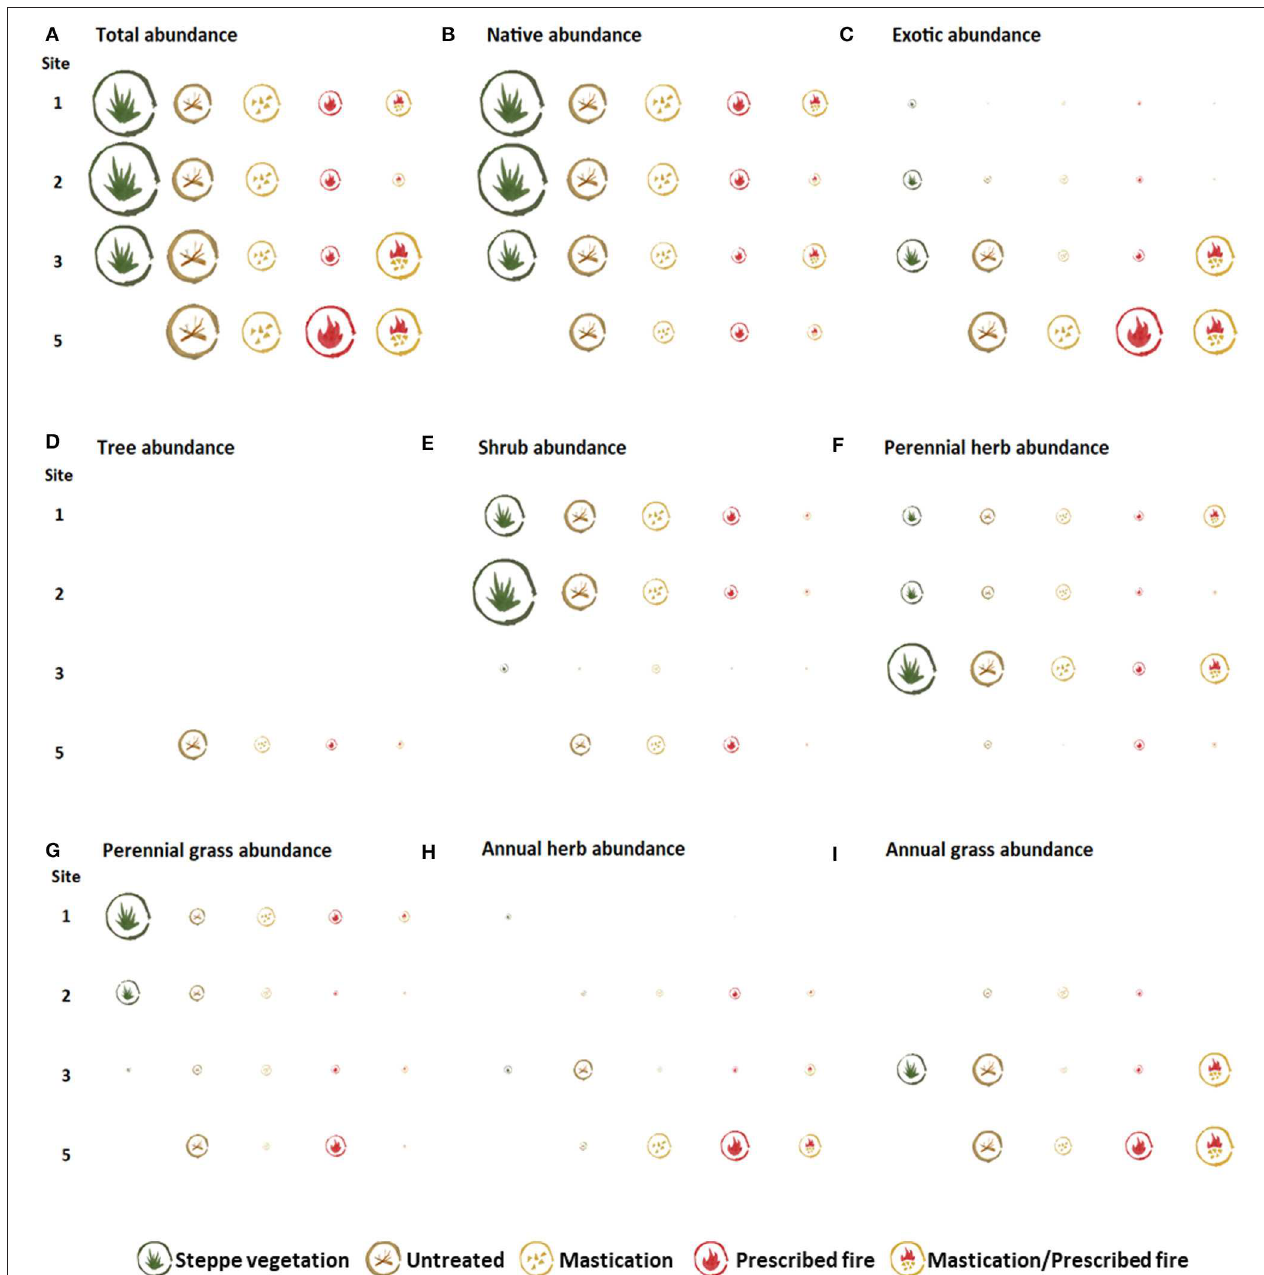
FIGURE 9 | Representation of total abundance (A) , and by origin (B,C) and growth form (D–I) , in the steppe vegetation and fuel treatments the last sampling year in each study site. Icon size corresponds to variables’ mean value (ranging from 0.50 to 50.75% cover) for each treatment.